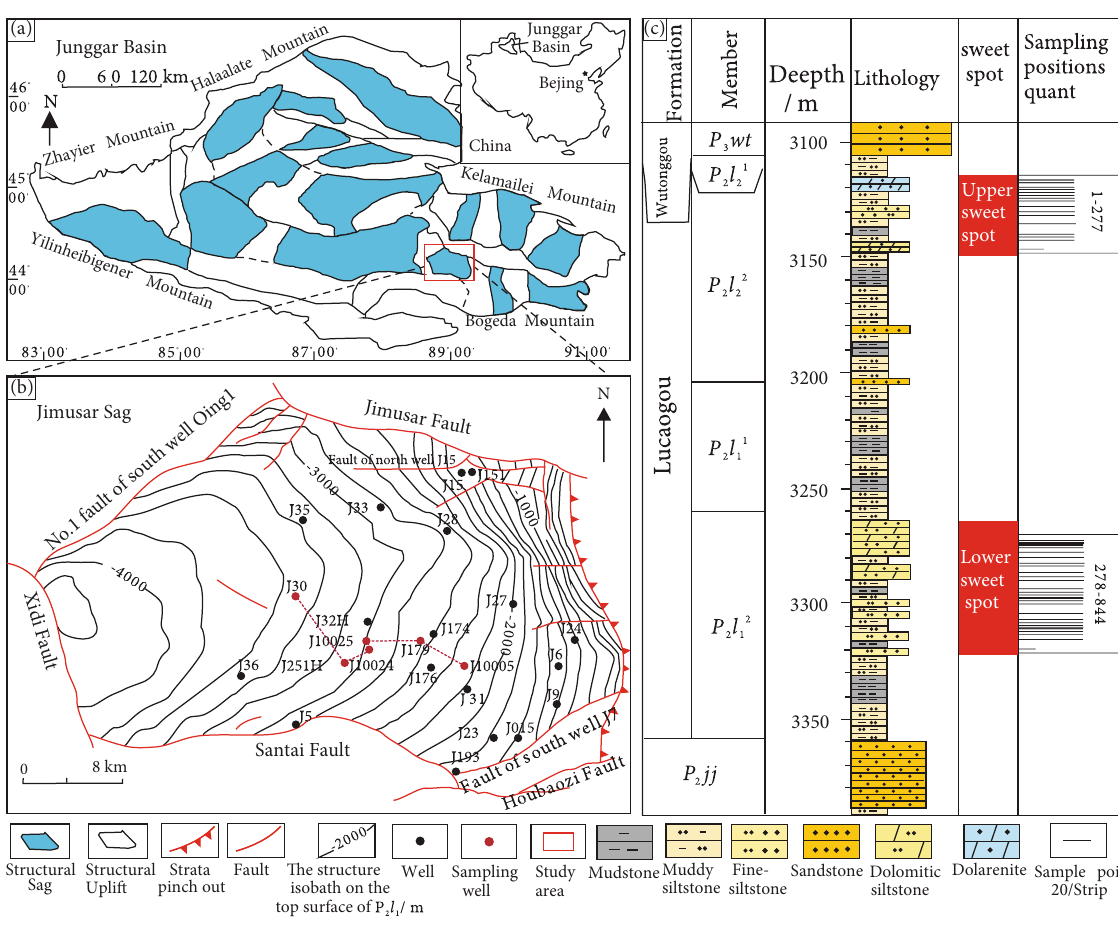
Figure 1: Location of the Jimsar Sag in the Junggar Basin (a). Structure contour map of the Middle Permian Lucaogou Formation in the Jimsar Sag (b). Stratigraphic column of the Lucaogou Formation and location of the samples (c) (modi fi ed from Xi et al., 2015 and Liu et al.,